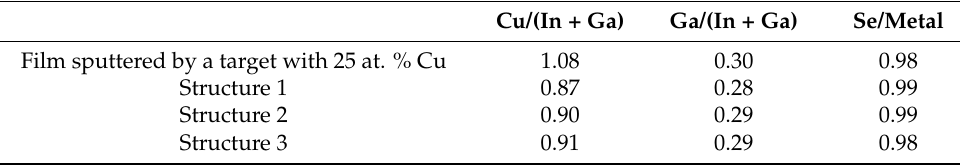
Table 1. Chemical compositions (measured by XRF) of the sputtered films. Cu/(In + Ga) Ga/(In + Ga) Se/Metal Film sputtered by a target with 25 at. % Cu 1.08 0.30 0.98 Structure 1 0.87 0.28 Structure 2